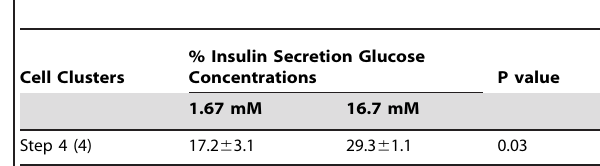
Table 2. Glucose-stimulated insulin